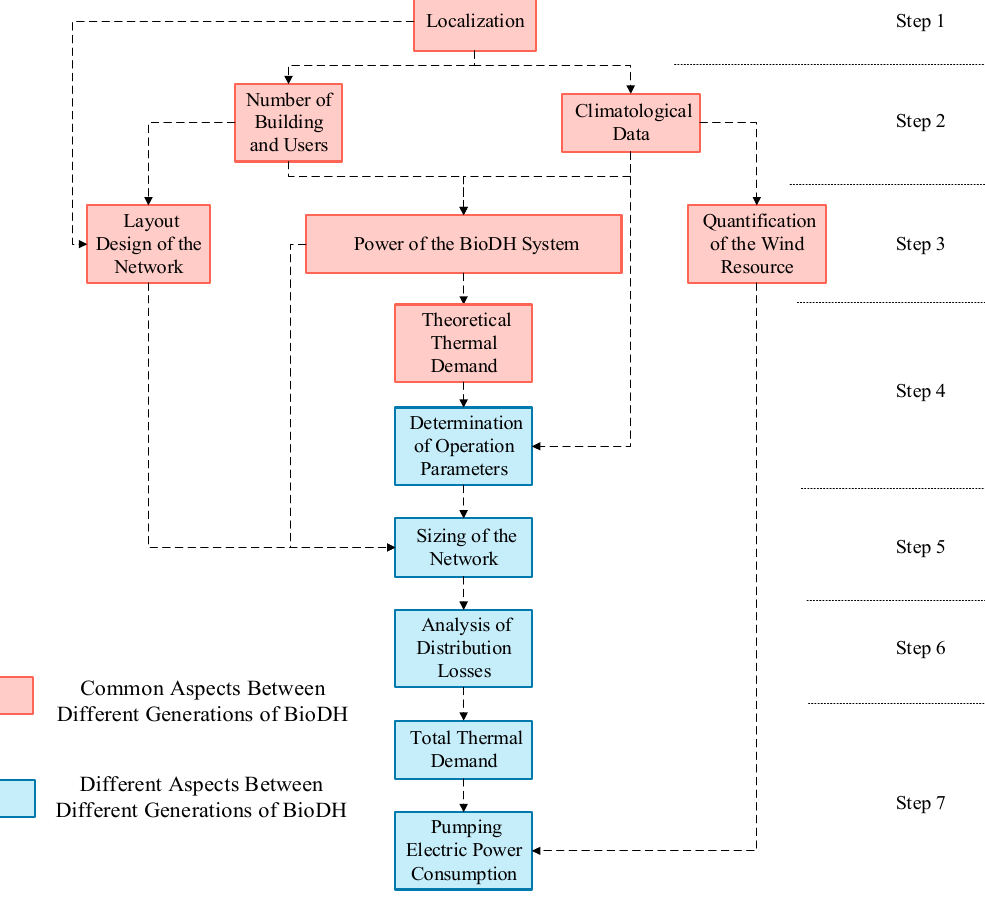
Figure 1. Stage I methodology.